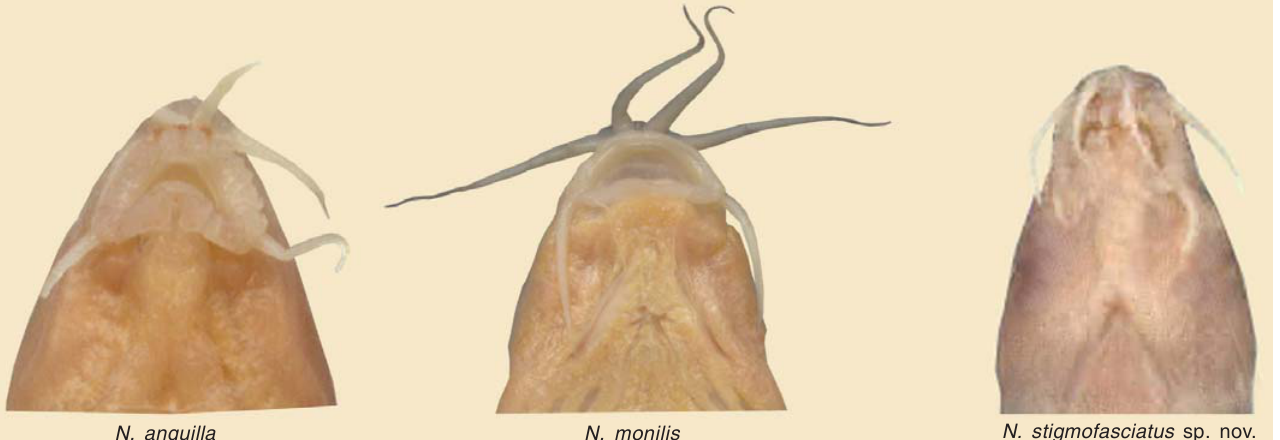
N. stigmofasciatus sp. nov. N. monilisN. anguilla